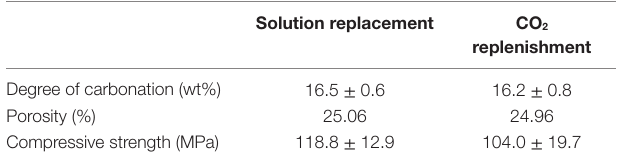
TaBle 4 | comparison of the 12-day “solution replacement” and the 12-day “cO 2 replenishment”